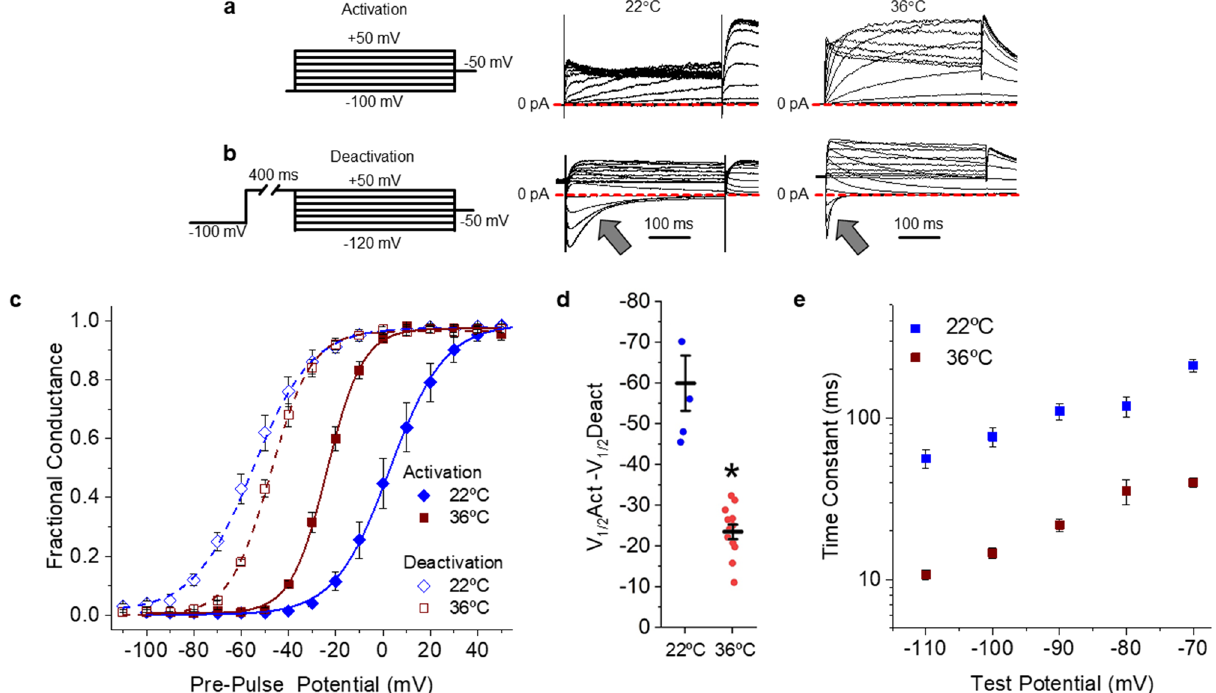
Figure 2. Physiological temperature reduces hERG 1a hysteresis of ionic currents. ( a ) Pulse protocol and corresponding sample ionic traces showing hERG 1a activation when stably expressed in HEK293 cells recorded at room temperature (22 °C, middle) or physiological temperature (36 °C, right). ( b ) Pulse protocol and corresponding sample ionic traces showing hERG 1a deactivation when stably expressed in HEK293 cells recorded at room temperature (22 °C, middle) or physiological temperature (36 °C, right). ( c ) Temperature-dependent shift in hERG 1a voltage dependence. Normalized peak tail current, representing fractional conductance, is plotted as a function of pre-pulse potential and fitted with a Boltzmann function for recordings completed at 22 °C (blue diamonds) and 36 °C (red squares). Channel activation recorded as in “( a )” is shown with solid symbols. Channel deactivation recorded as in “( b )” is shown with open symbols. ( d ) The magnitude of hysteresis was quantified by subtracting the V 1/2 of deactivation from the V 1/2 of activation. Hysteresis was significantly smaller in recordings completed at 36 °C ( n = 12) compared with recordings at 22 °C ( n = 5). ( e ) Time constants representing the fast deactivation time course for hERG 1a current recordings completed at either 22 °C (blue) or 36 °C (red). We fit current decay (arrows in “ b ”) with a double exponential equation (Eq. 4) and reported the fast time constant (τ) as a function of test potential. All data are reported as mean ± SEM. * indicates p <